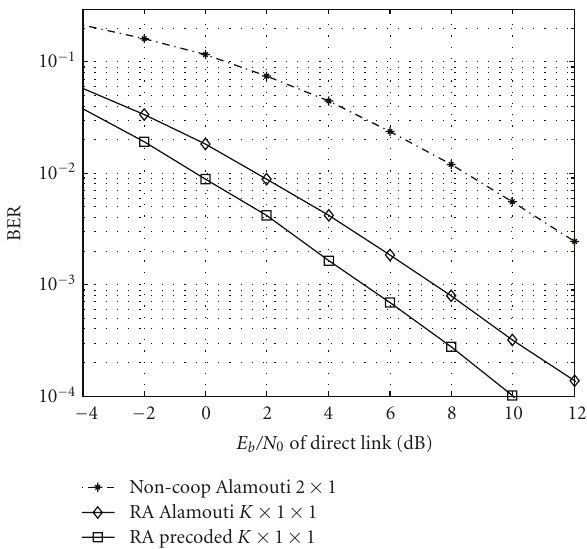
Figure 12: BER of cooperative systems with 1 antenna per relay and of reference systems for Scenario